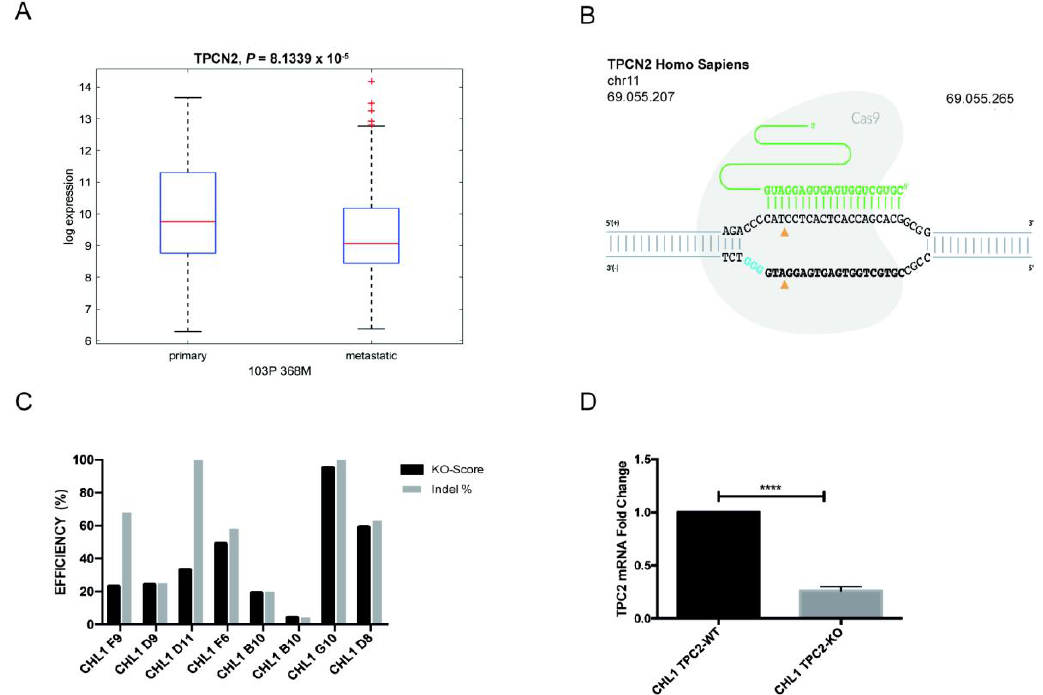
Figure 1. TPC2 expression in the melanoma patient dataset and the generation of a human melanoma cell model TPC2 knockout. ( A ) Analysis of expression and prognostic value for TPC2 between primary and metastatic patients in human skin cutaneous melanoma (SKCM). Dashed line indicates 95% confidence interval ( p -value: 8.1339 × 10 −5 ). ( B ) Schematic of CRISPR-Cas9 strategy used to target CHL1 human melanoma cell line. ( C ) Interference of CRISPR Edits (ICE) Analysis of possible knockout (KO) clones, from which the CHL1 clone G10 was selected. KO score indicates the percentage of sequences that are putative knockouts. ( D ) qPCR analysis of TPC2 transcript levels in CHL1 (wild type (WT) and KO). Data in bar charts represent the mean ± s.e.m. of three independent experiments. **** p < 0.0001.